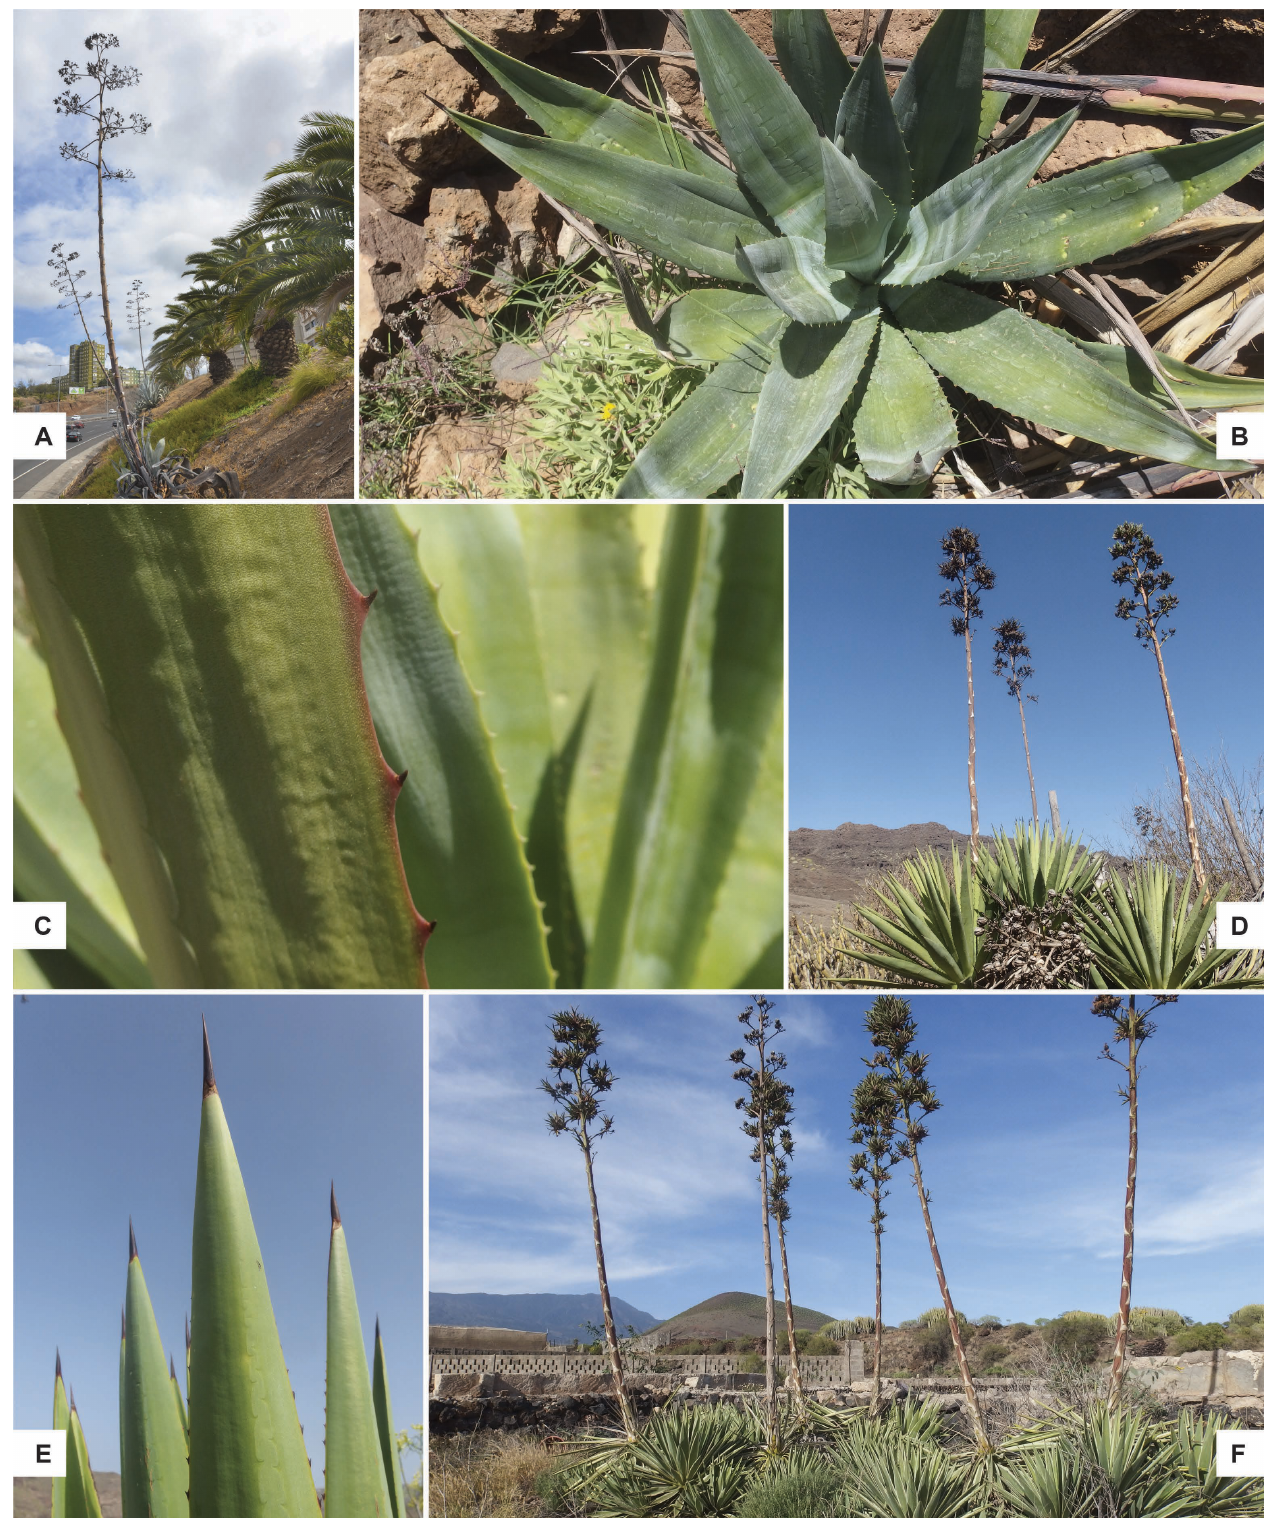
Figure 2 – A . Agave franzosinii , Las Palmas de Gran Canaria (La Paterna) (C), May 2018. This species has a somewhat laxer inflorescence than A. americana . B . A. murpheyi , Santa Lucía de Tirajana (C), April 2018. C . Idem. Detail of leaf marginal spines. D . A. angustifolia , Mogán (C), December 2017. Inflorescences are nearly always bulbiliferous in this species. E . Idem. Detail of leaf spination of green form. F . Idem, Güímar (T), January 2017. Photographs: A by Á. Marrero; B–F by F.